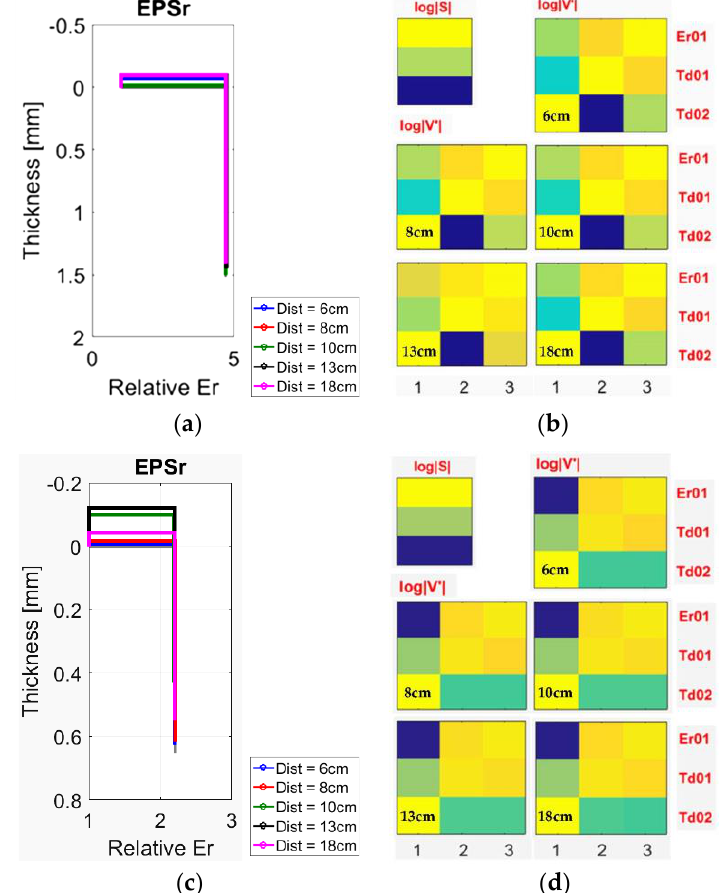
Figure 2. The parameters estimation for single-layer materials.